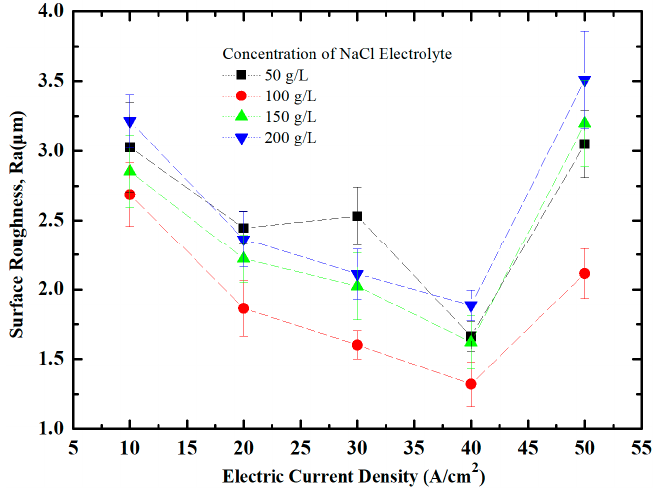
Figure 6. Surface roughness of workpiece at different current density.